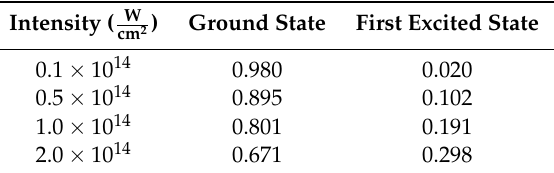
Table 1. Population of the ground state and the first excited state in coherent superposition states for different intensities computed at t = 270 a.u.